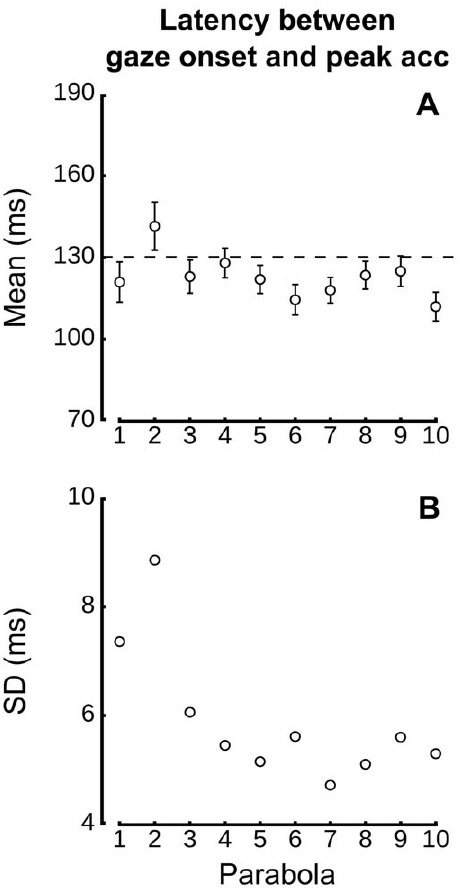
Figure 6. Decrease of variability of latency between times of peak hand acceleration and gaze saccade onset to the target across parabolas. Mean gaze latencies relative to peak hand acceleration (A) and standard deviations of mean latencies (B) across the 10 parabolas. The horizontal dashed line in the top panel is positioned at mean latency (132.6 ms). Panel B reports a strong decrease in variability within three parabolas.